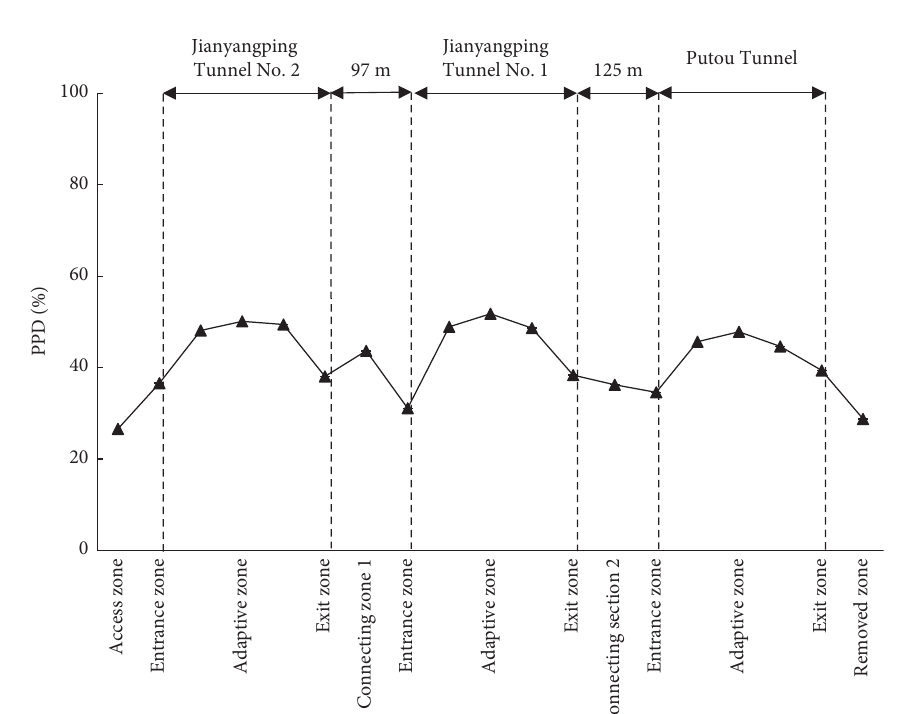
Figure 10: Zone analysis of Jianyangping Tunnel